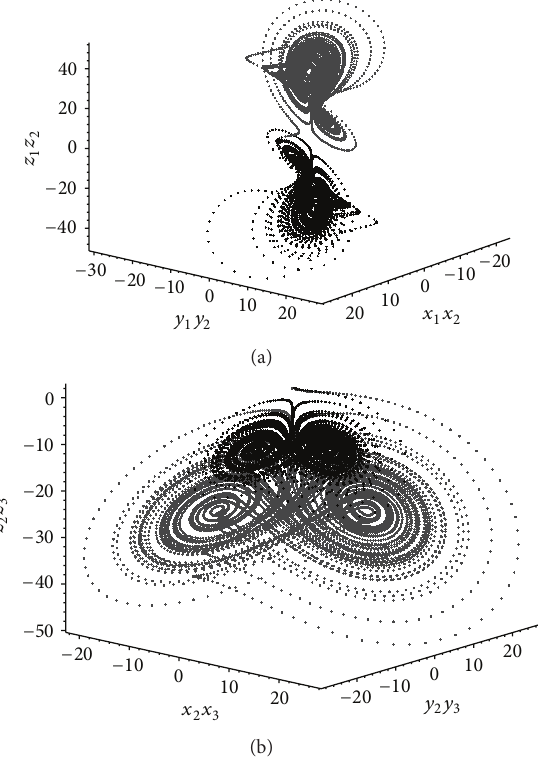
Figure 8: The chaos attractors between node 1 and node 2 (a) and between node 2 and node 3